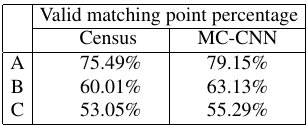
Table 3. Valid matching point percentage comparison between Census and MC-CNN